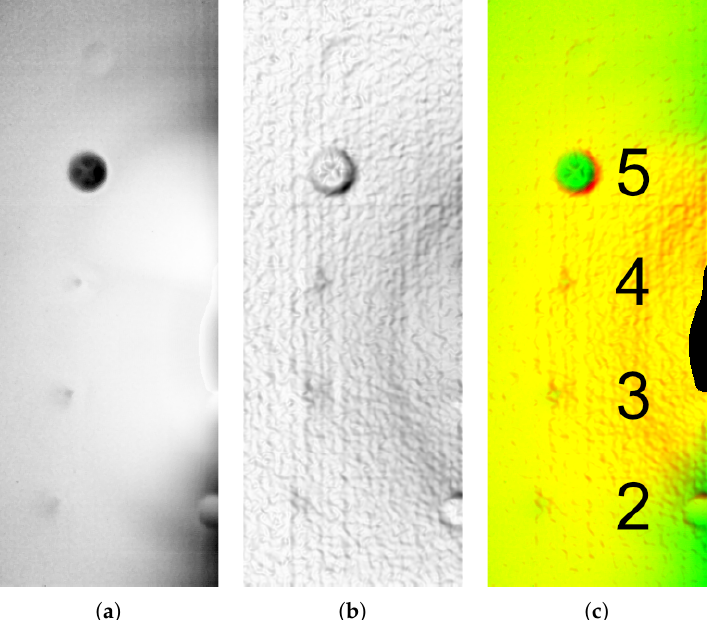
Figure 6. IPHWT of area II with the resulting covariance analysis ( a ) and local gradient method ( b ). In ( c ), both outputs are composed and green corresponds to the covariance analysis and red to the local gradient method. Additionally, the identified heating area is indicated in black at the top right